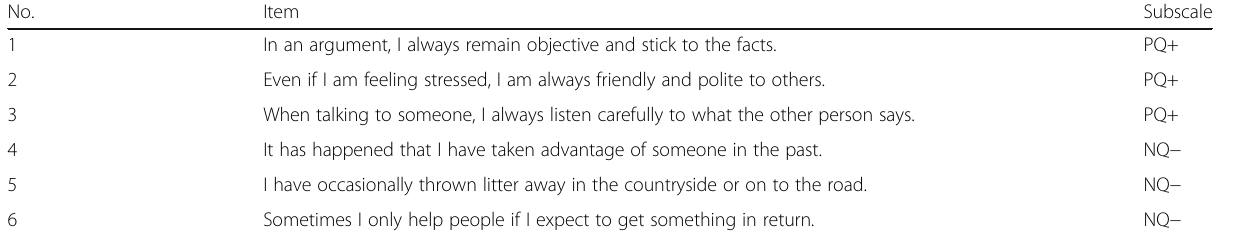
Table 2 Items of the English-Language Adaptation of the Social Desirability – Gamma Short Scale No. Item Subscale In an argument, I always remain objective and stick to the facts. Even if I am feeling stressed, I am always friendly and polite to others. When talking to someone, I always listen carefully to what the other person says. It has happened that I have taken advantage of someone in the past. I have occasionally thrown litter away in the countryside or on to the road.